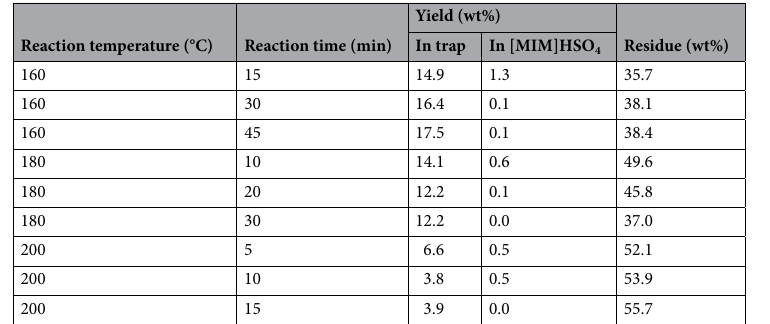
Reaction temperature